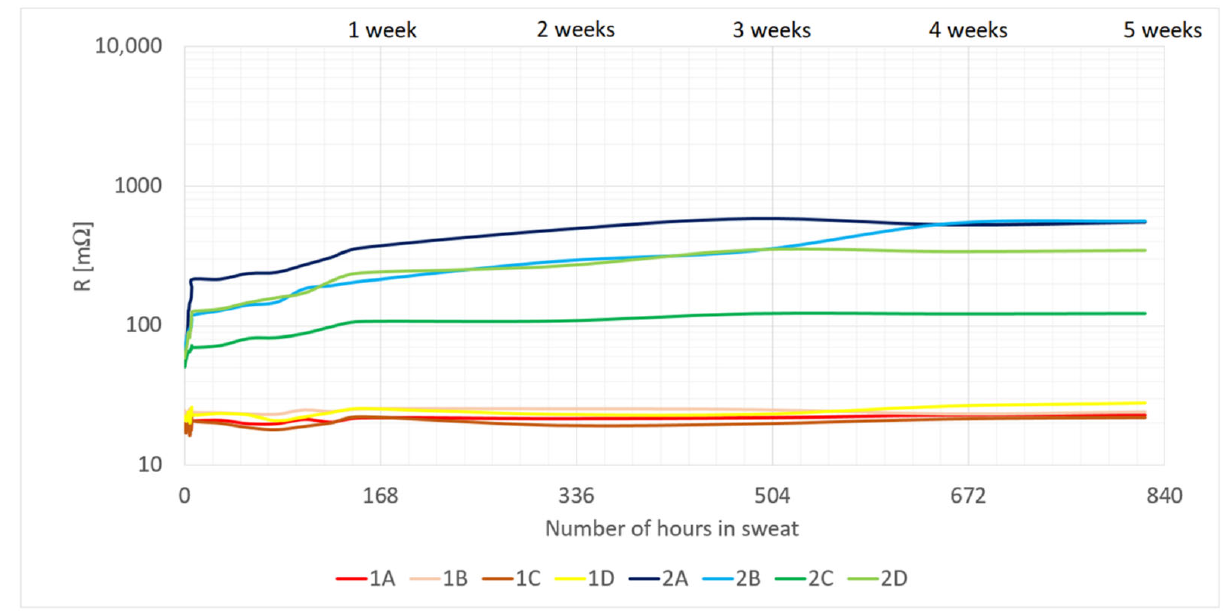
Figure 8. Medians of electrical resistance for the first (1A, 1B, 1C, 1D) and second (2A, 2B, 2C, 2D) sample types tested under sweat.